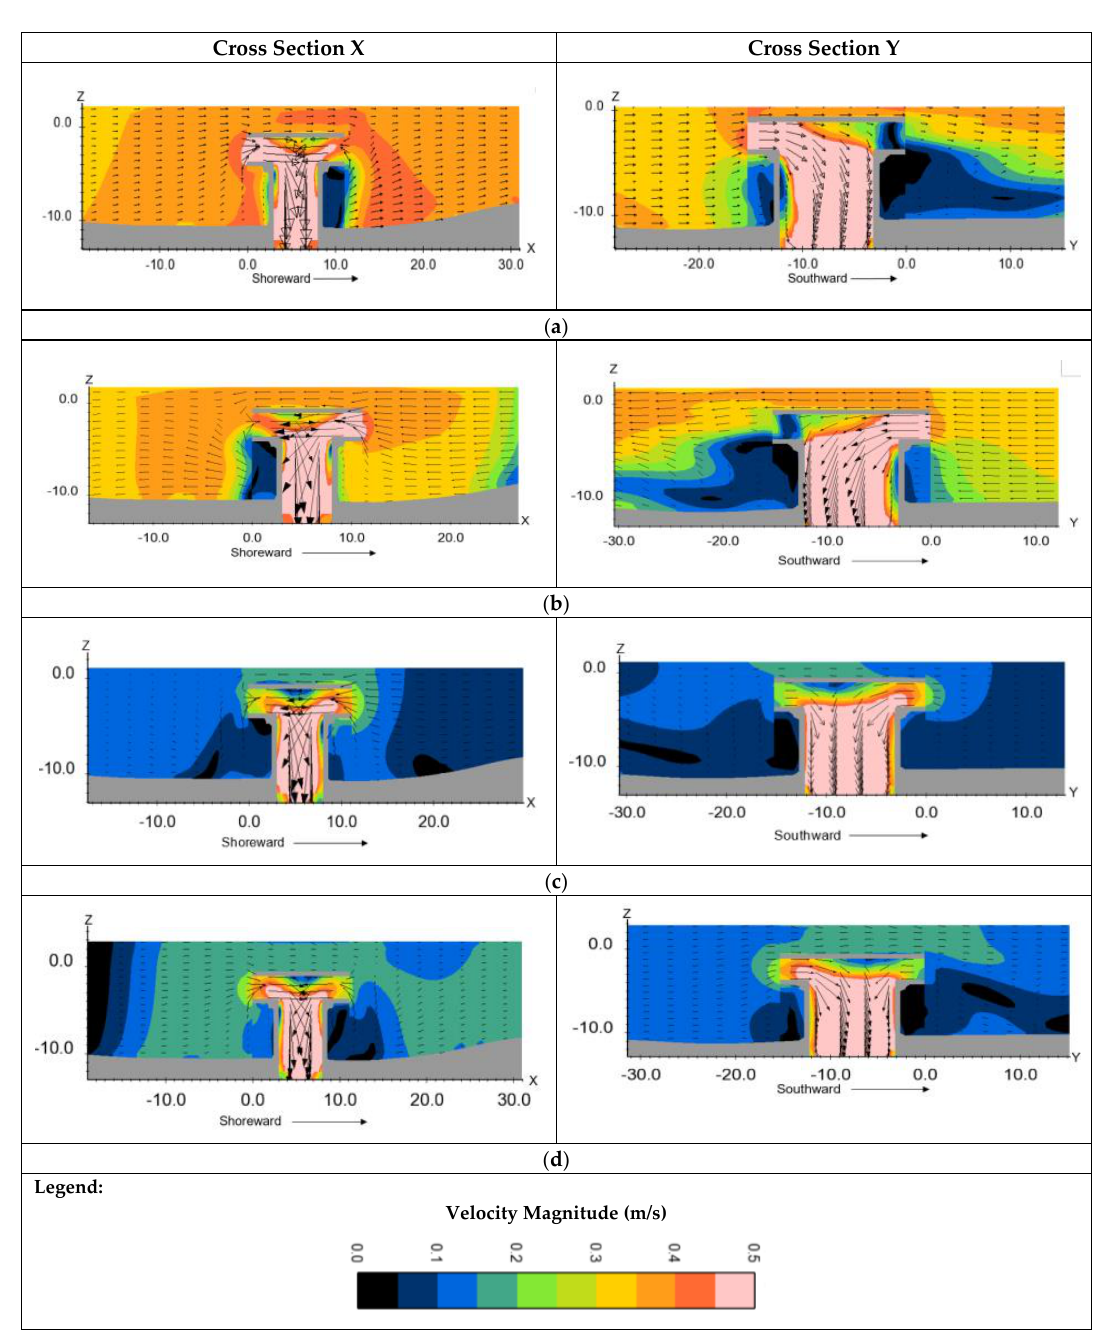
Figure 8. Simulation of flow field around the existing intake structure during flood, ebb, and slack currents ( a ) Flood Current; ( b ) Ebb Current; ( c ) Slack Ebbing Current; ( d ) Slack Flooding Current.